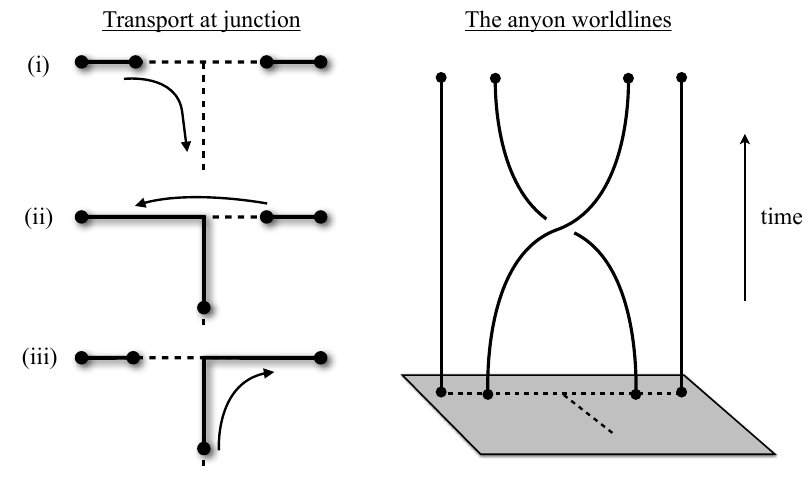
Figure 10: Braiding Majorana modes at a T-junction of superconducting nanowires, where the chemical potential µ in the Hamiltonian (29) is locally tunable. Dashed lines denote domains in the trivial phase ( | µ | > t ), solid lines domains in the topological phase ( | µ | < t ) and the dots denote the locations of Majorana zero modes. In the even fermion parity sector ( (cid:80) = 1) the two-fold degenerate ground state of this system is spanned by the states (35) and sepa- rated from excited states containing an even number ψ excitations by an energy gap of 2 ∆